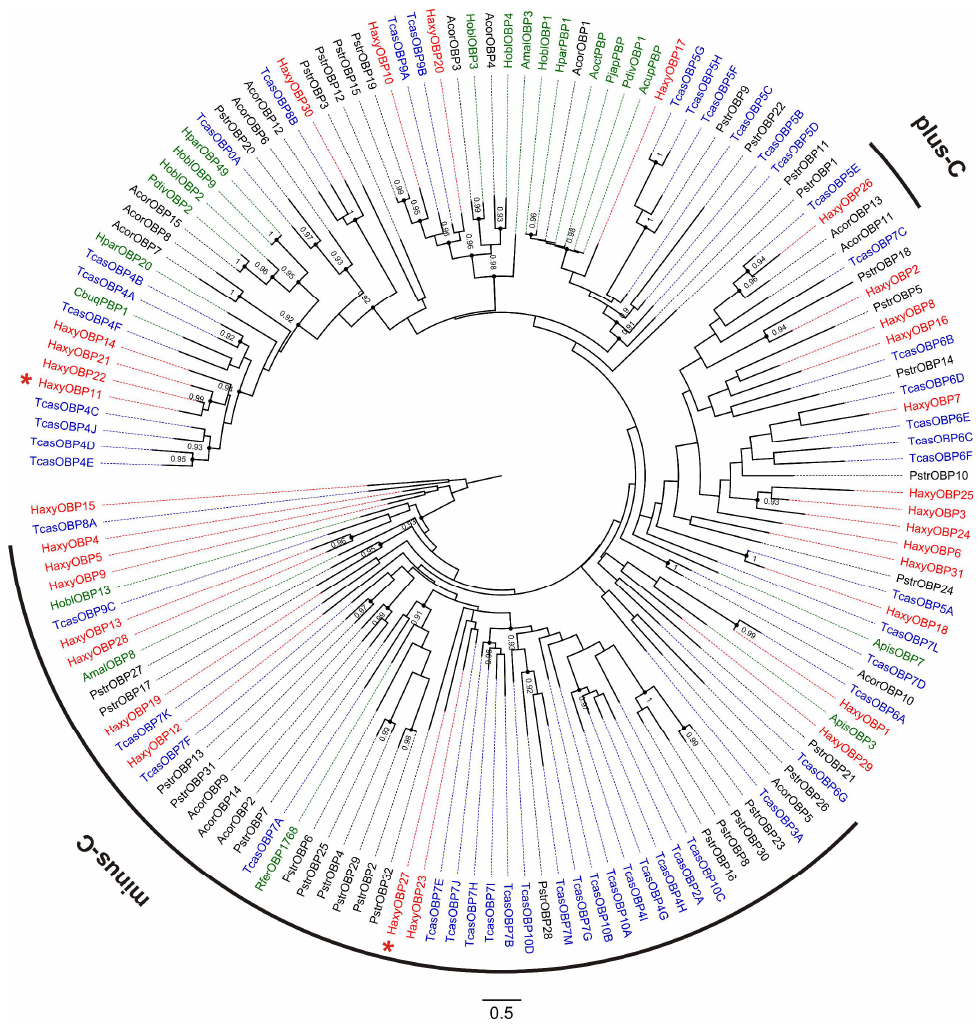
Figure 4. Phylogenetic tree of odorant-binding proteins (OBPs). Red: Harmonia axyridis (Haxy); blue: Tribolium castaneum (Tcas); black: Anomala corpulenta (Acor) and Phyllotreta striolata (Pstr); green: functionally characterized OBPs and pheromone binding proteins (PBPs) from Acyrthosiphon pisum (Apis), Anomala cuprea (Acup), Agrilus mali (Amal), Anomala octiescostata (Aoct), Cyrtotrachelus buqueti (Cbuq), Holotrichia oblita (Hobl), Holotrichia parallela (Hpar), Phyllopertha diversa (Pdiv), Popillia japonica (Pjap), Rhynchophorus ferrugineus (Rfer). Numbers and symbols at nodes represent support values higher than 0.9, where 1 represents maximal support. Asterisks represent the two OBPs with male-biased expression.